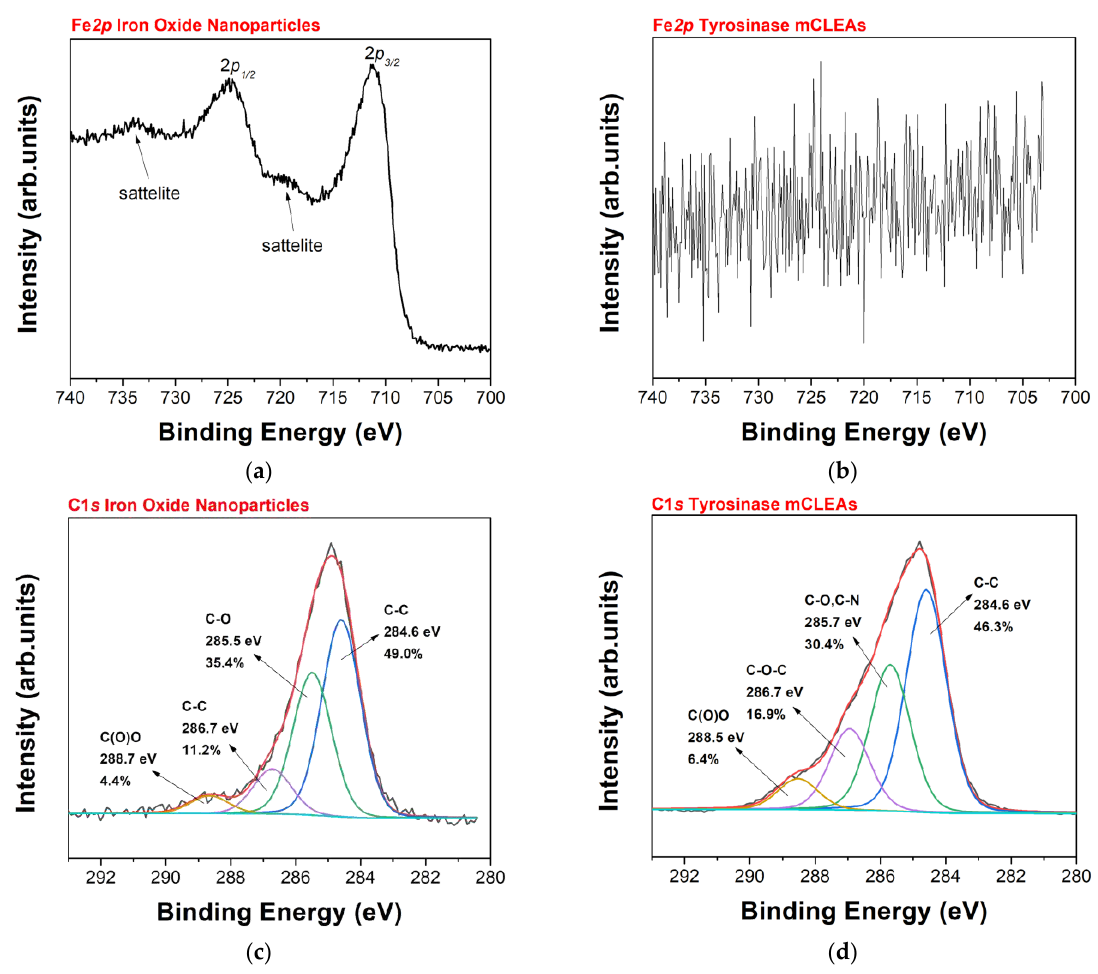
Figure 2. XPS spectra of the Fe 2p core level region of ( a ) iron oxide nanoparticles; ( b ) tyrosinase mCLEAs and XPS spectra of the C1 s core level region of ( c ) iron oxide nanoparticles; ( d ) tyrosinase mCLEAs.